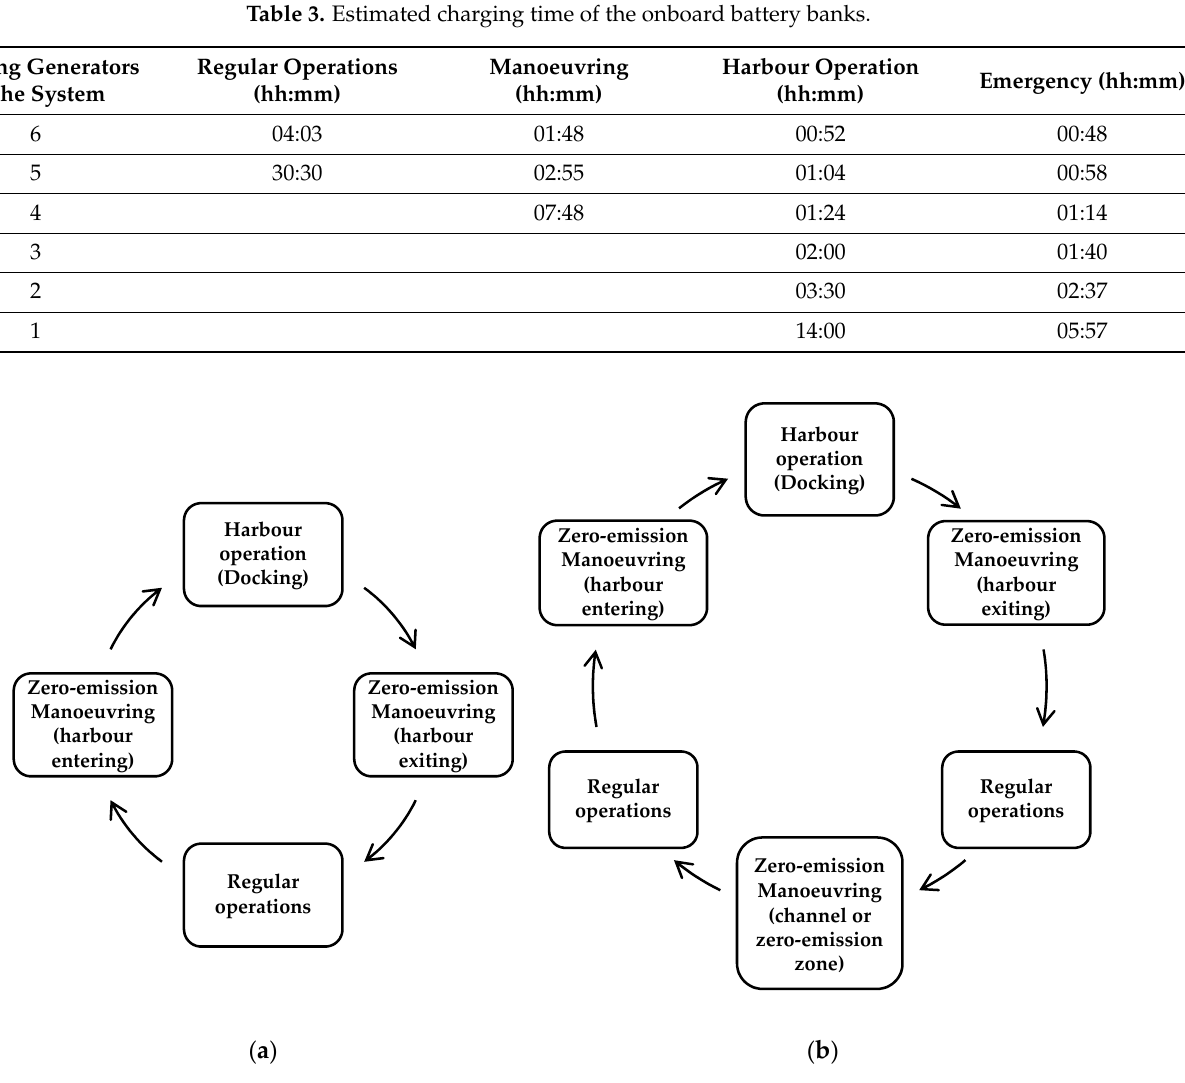
Figure 12. Types of the vessel missions ( a ) variant 1 ( b ) variant 2.